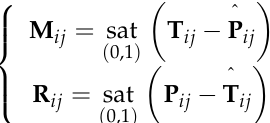
contour’s label T and probability map P , as shown in Figure 4a,d. The blue boxes in Figure 4a indicate pixels labeled as tube contour, the red boxes in Figure 4d indicate pixels predicted as tube contour and the green curve indicates the real position of tube